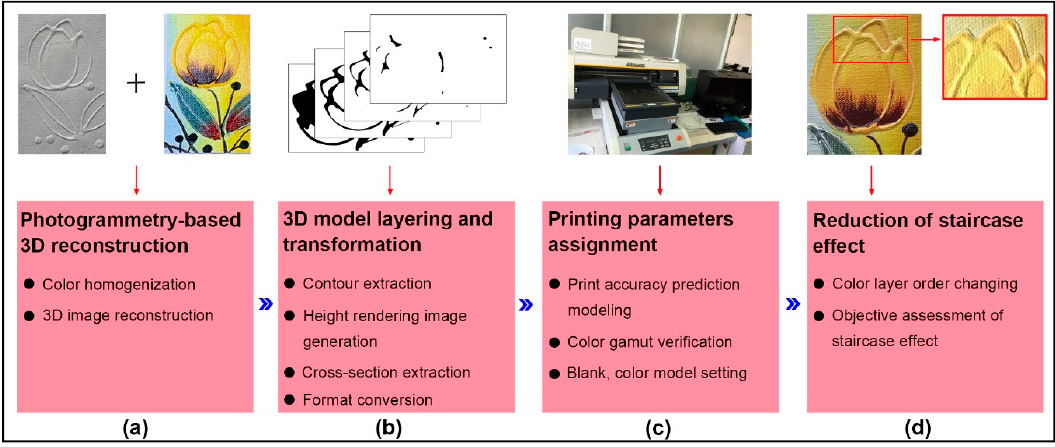
Figure 1. The framework of our proposed method for a 3D-printed oil painting.